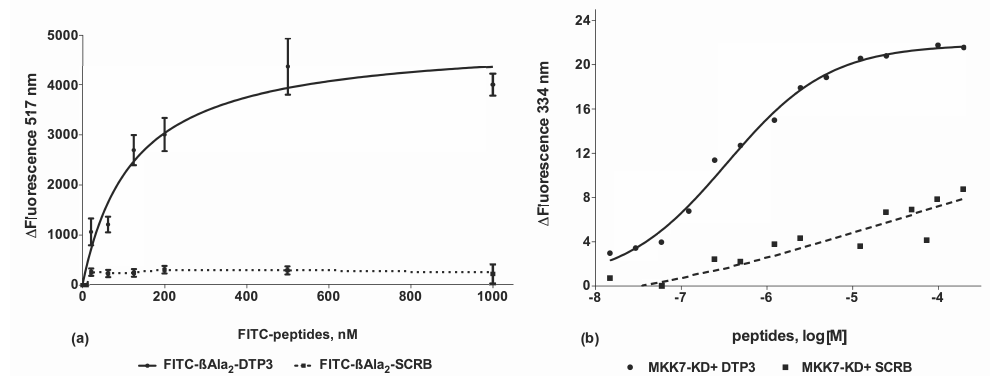
Figure 2. Fluorescence quenching binding analysis of N-terminally fluoresceinated DTP3 to MKK7- KD. ( a ) ∆ Fluorescence values at 517 nm of FITC- β Ala 2 -DTP3 and FITC- β Ala 2 -SCRB (10 nM) plotted against the concentration of MKK7-KD (0.05 ÷ 1000 nM) are reported. Values denote means ± SD (n = 4). ( b ) Fluorescence quenching binding analysis of DTP3 and SCRB to MKK7-KD as obtained by monitoring the ∆ Fluorescence at 334 nm. ∆ Fluorescence values plotted against the concentration of peptides (10 nM ÷ 140 µM) are reported. Values denote means ± SE (n =